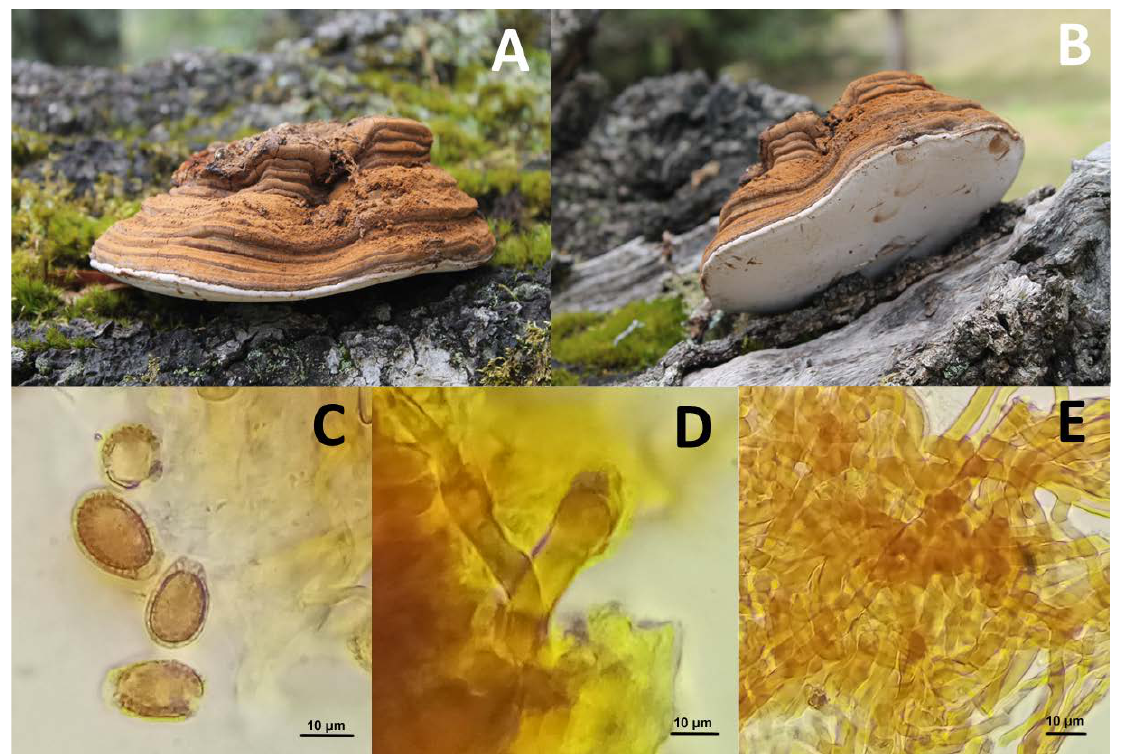
Figure 1. Ganoderma aff. australe . Appearance of Basidiome ( A ), Hymenophore ( B ), Basidiospores ( C ), Basidia ( D ), Hyphae ( E ). Scale bar = 10 µm (100×), binocular microscope. Font: ( A , B ) Rocio Peña- Cañón; ( C – E ) Yeina Niño.